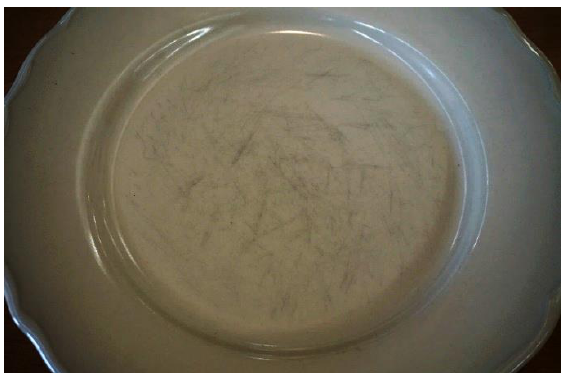
Figure 1. Metal marks on a dinner